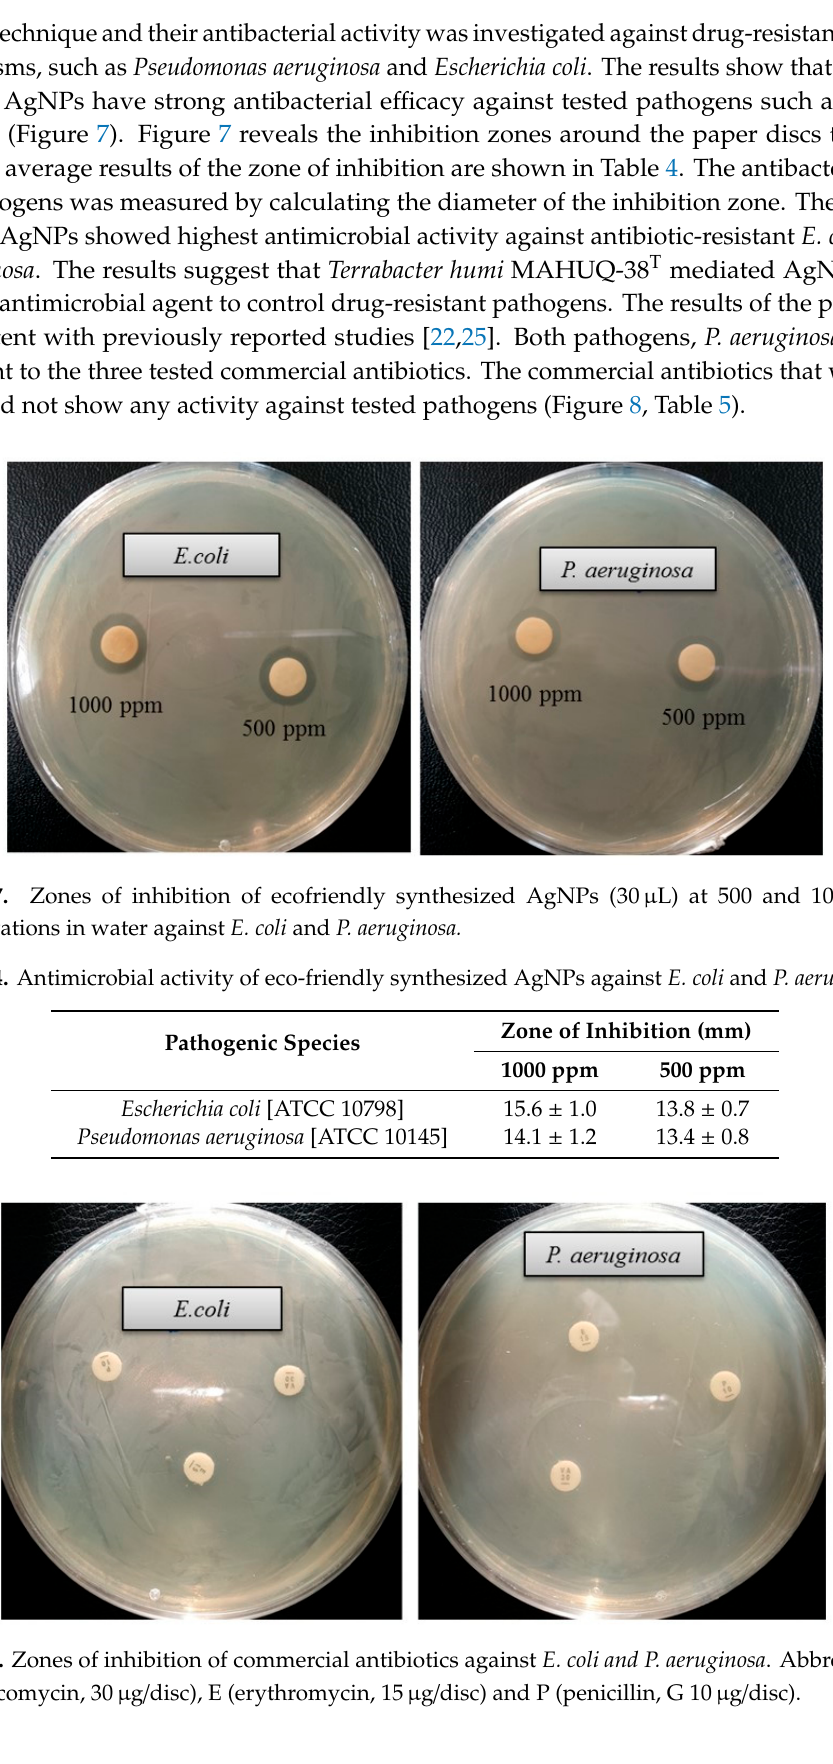
Figure 8. Zones of inhibition of commercial antibiotics against E. coli and P. aeruginosa . Abbreviation: VA (vancomycin, 30 µ g / disc), E (erythromycin, 15 µ g / disc) and P (penicillin, G 10 µ g / disc). Table 4. Antimicrobial activity of eco-friendly synthesized AgNPs against E. coli and P. aeruginosa . Table 5. Antimicrobial activity of commercial antibiotics against E. coli and P. aeruginosa .